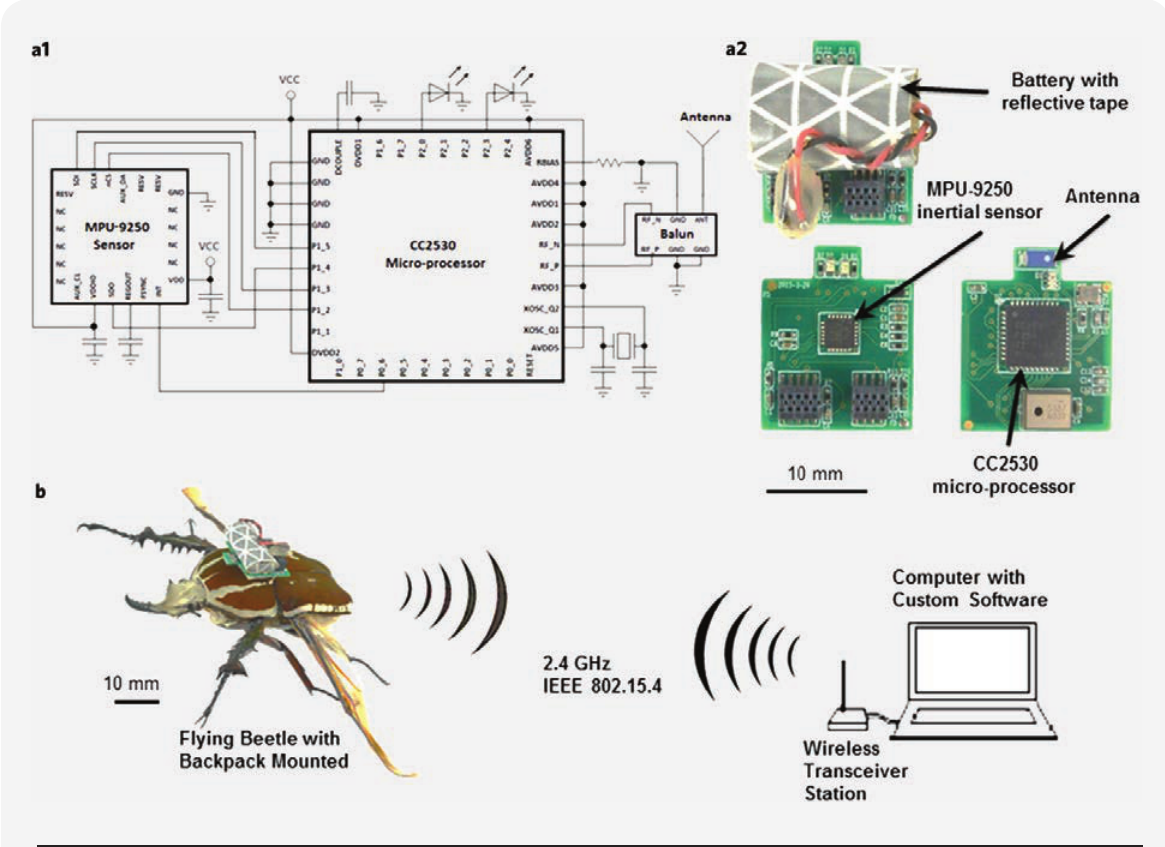
Figure 3. An inertia sensor implemented in a backpack. Schematic design (a1) and fi nished fabrication (a2) of a wireless backpack with an inertia sensor (dimensions: 15 mm × 15 mm; masses: printed circuit board assembly = 640 mg, assembly with battery = 1310 mg). (b) Attached to a beetle, the backpack could communicate wirelessly with a computer via a transceiver station (IEEE 802.15.4 protocol). Data from the inertia sensor were processed and transmitted to the computer at a sampling rate of 100